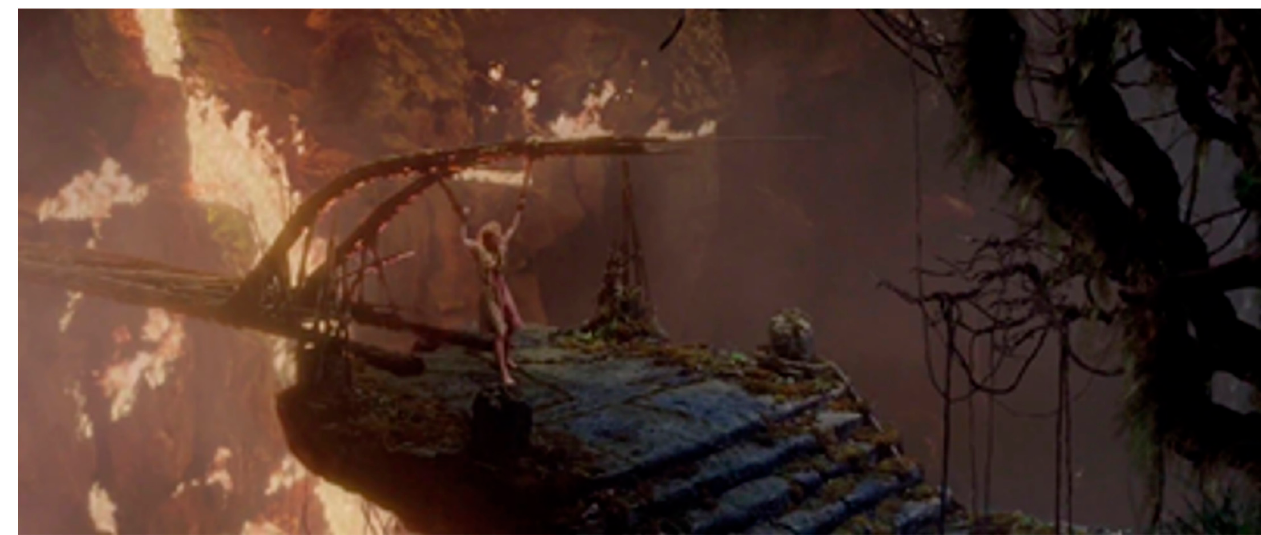
Figure 24. The woman is sacrificed on an altar surrounded by fire (2005). https://quotesgram.com/king-kong-2005-quotes/ (accessed on 1 January 2021).